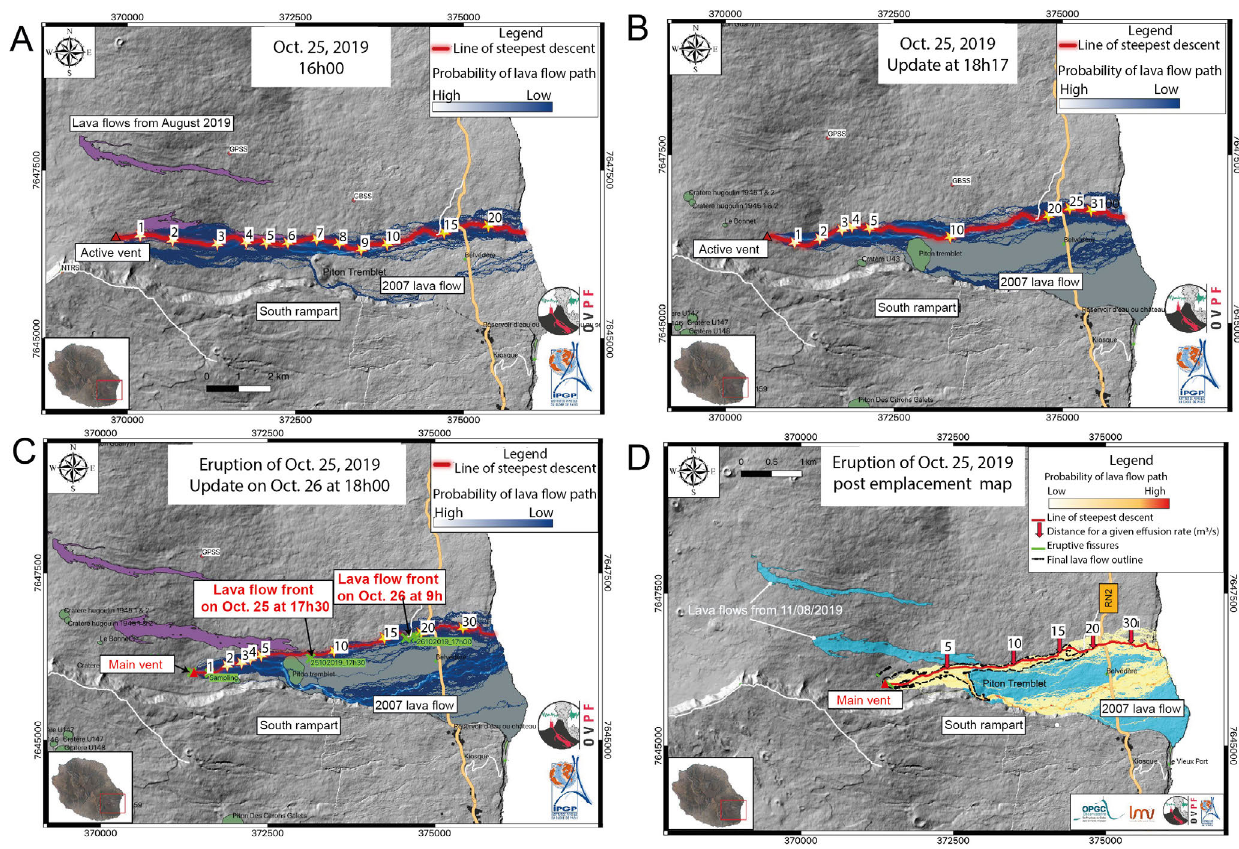
Figure 3: [A] First map produced on 25 October, 2019 at 16:00 RET with the location of the vent estimated from the tremor map. Yellow stars represent the distance at which lava could extend along the LoSD for a given TADR (numbers are in m 3 s − 1 ). [B] Update of the map produced on 25 October, 2019 at 18:17 with the location of the vent estimated during a helicopter overflight. [C] Update of the map produced on 26 October, 2019 at 18:00 with the location of the vent and the lava flow front obtained during field survey. [D] Final map showing the probability of lava flow invasion, red arrows represent the runout distances as a function of discharge rate. The fissure locations and final lava flow outline obtained by photogrammetry are also given in green and black, respectively. This map was produced after the end of the eruption and published in the OVPF monthly report of October 2019 [OVPF